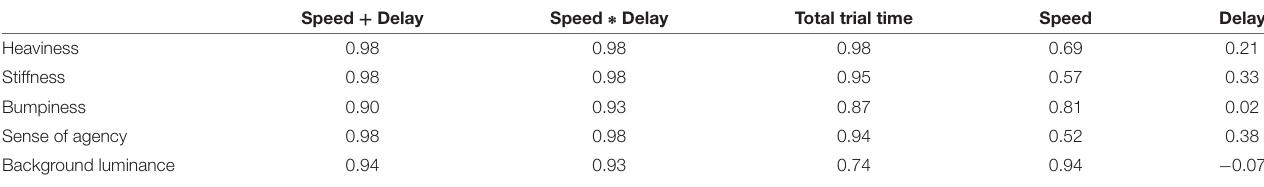
TABLE 6 | Adjusted coefficients of determination for each